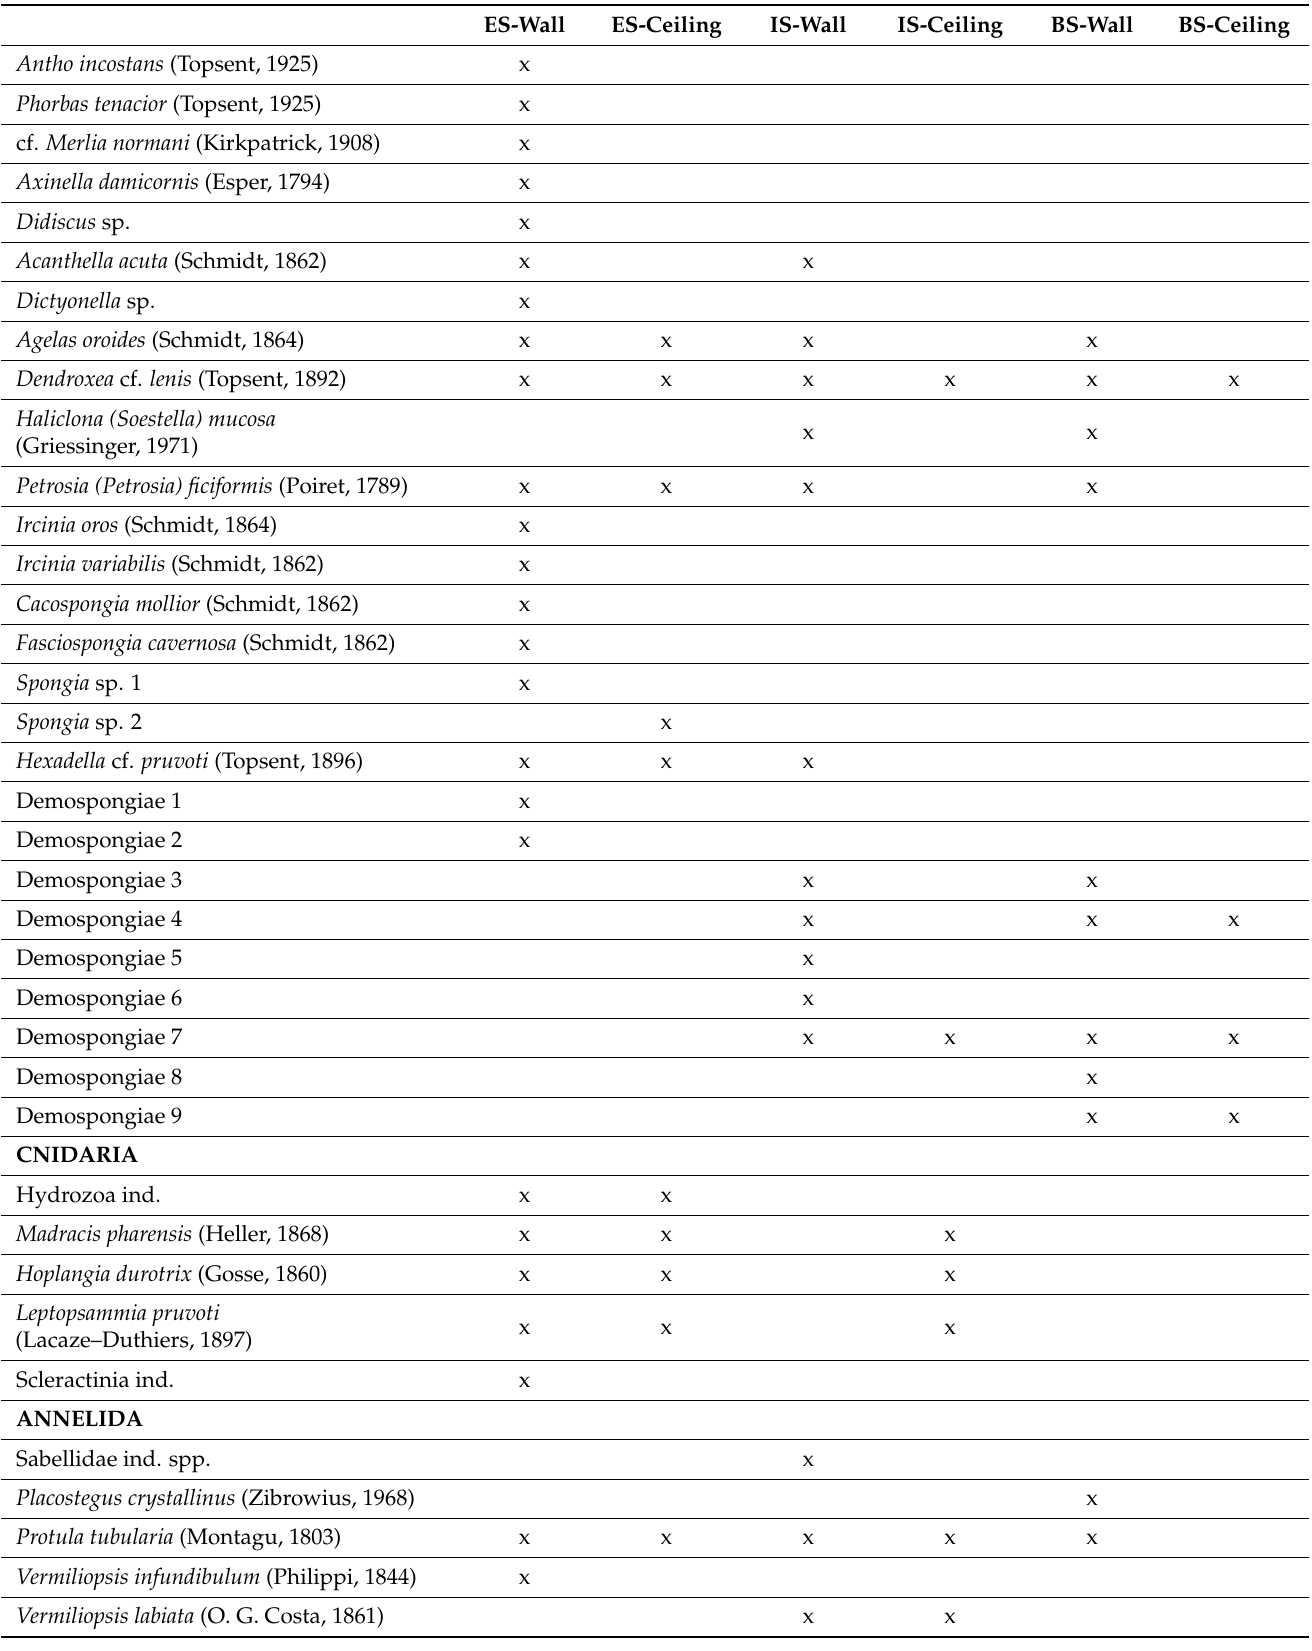
Table 5. Cont. ES-Wall ES-Ceiling IS-Wall IS-Ceiling BS-Wall